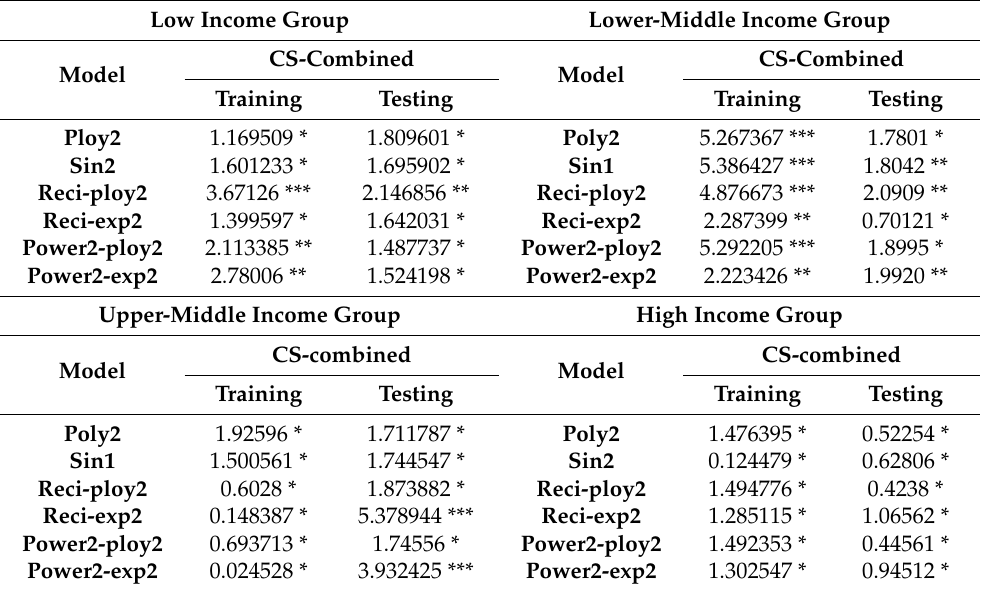
Table 6. Diebold–Mariano (DM) test of five different models for four different income